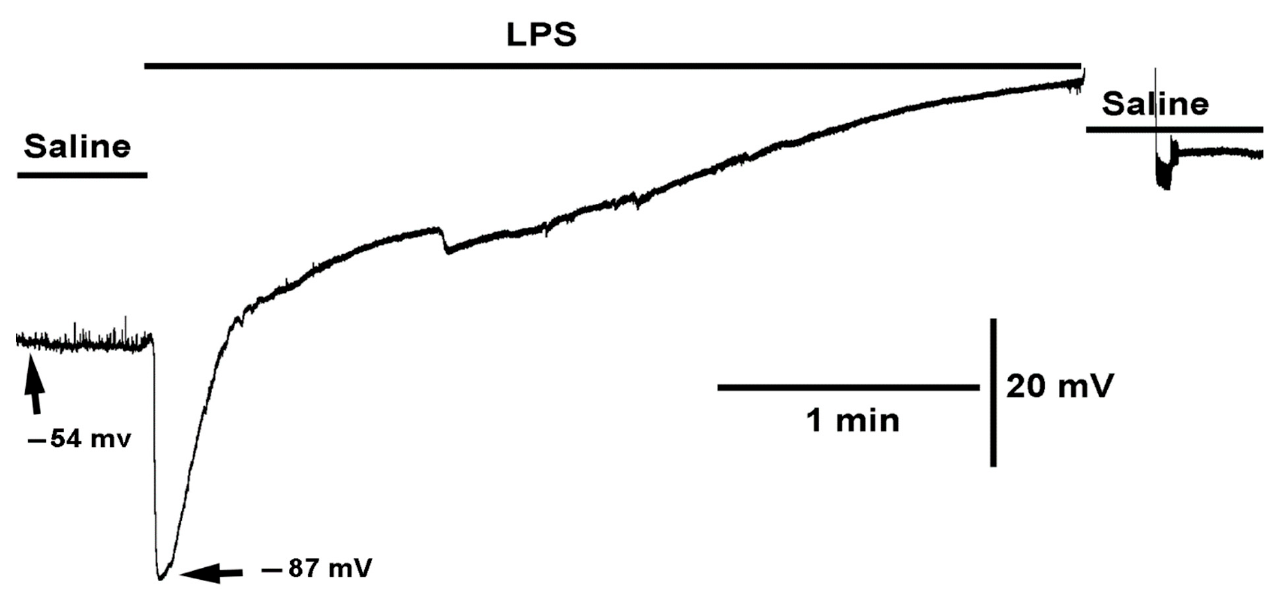
Figure 1. The effect of LPS on membrane potential and synaptic transmission. LPS rapidly hyperpo- larized the muscle as well as blocked the receptors to glutamate as the spontaneous quantal events (miniature excitatory junction potentials, mEJPs) were no longer observed even though there was an increased driving force. With prolonged exposure to LPS the membrane potential depolarizes to zero.